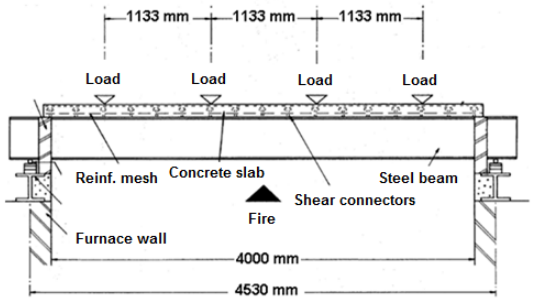
Figure 2. Test arrangement longitudinal section (Source: adapted from Wainman